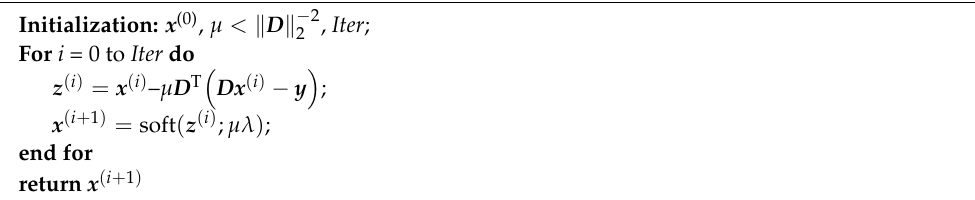
Algorithm 1. Iterative shrinkage-thresholding algorithm.